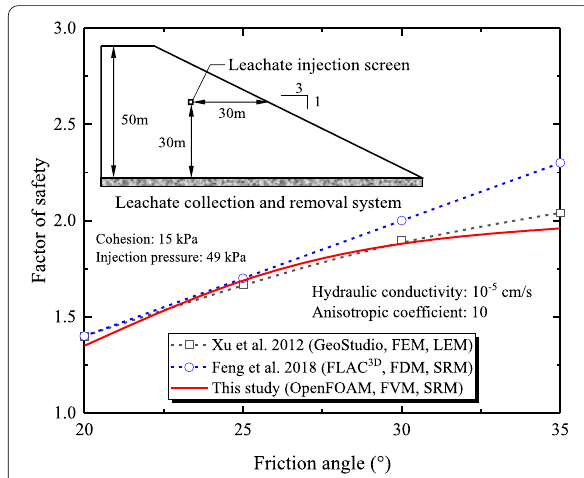
Fig. 3 Comparison of the relationships between FS and friction angle obtained by Feng et al. (2018), Xu et al. (2012) and the proposed model